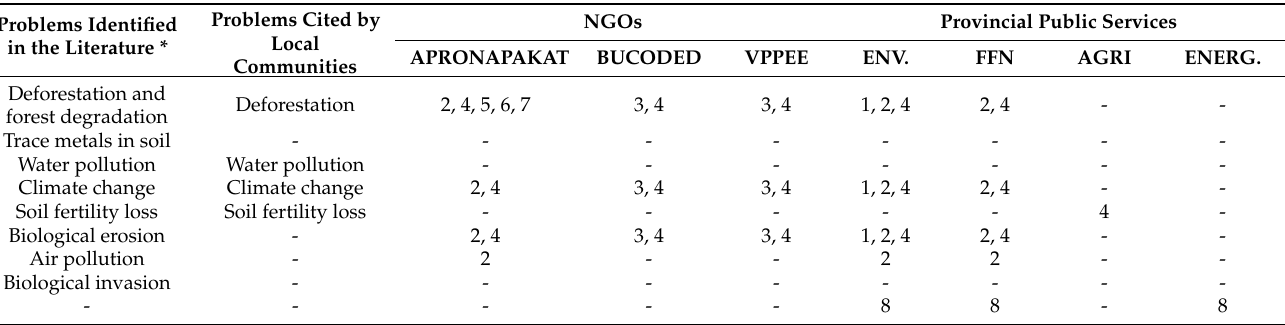
Table 6. Suitability of the actions of the NGOs/provincial public services to the problems identified in the literature and by the local communities.